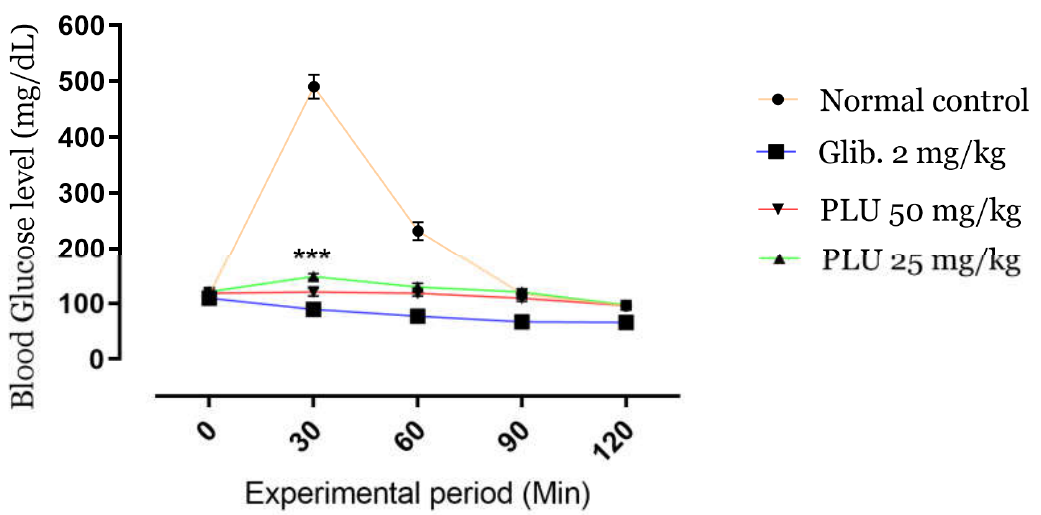
Figure 3. Effects of PLU on BGLs during the OGTT. Values are represented as means ± SD ( n = 5 mice). *** p < 0.001 compared to normal controls.